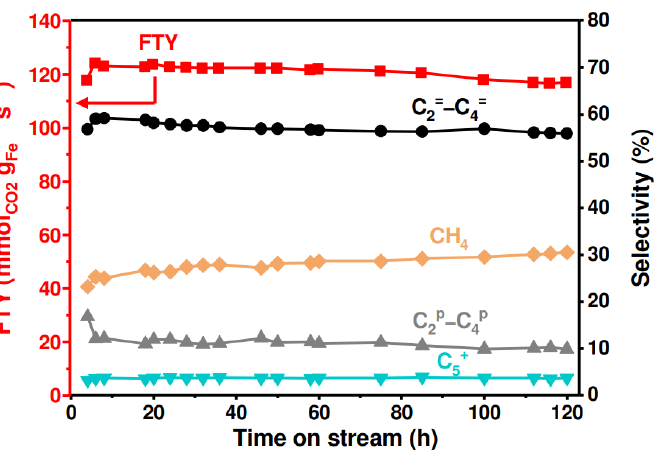
Figure 3. FTY and hydrocarbons selectivity in CO 2 −FTO over the FeK(1.5) /Gr(3D) catalyst (0.15 g catalyst, H 2 /CO 2 = 3, T = 340 °C, p = 20 bar, space velocity of 26 L h −1 g −1 ) (reprinted with permission from Ref. [45] © 2018, American Chemical Society Inc., Washington, DC, USA). Table 4. Graphene-based catalysts for CO 2 reduction to high hydrocarbons and to CO.